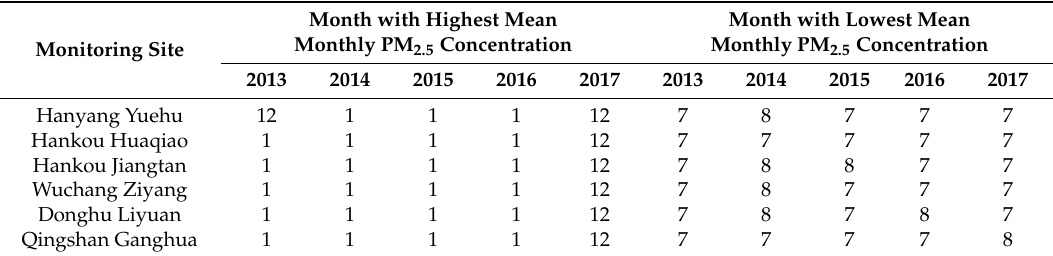
Table 3. Months with highest and lowest mean monthly PM 2.5 concentration at various stations. Month with Highest Mean Monthly PM 2.5 Monitoring Site